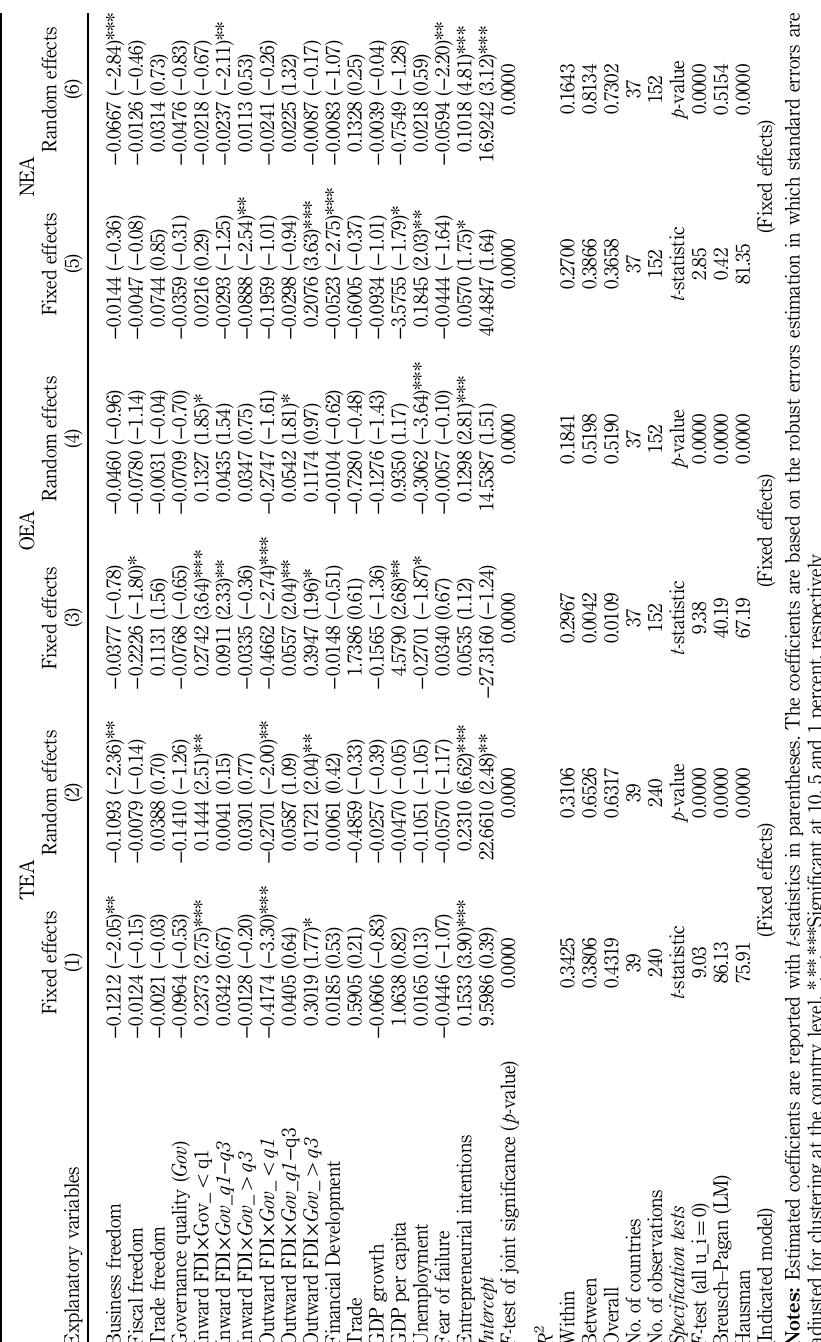
Table VI. Governance quality, FDI and entrepreneurship: the three-interval Gov